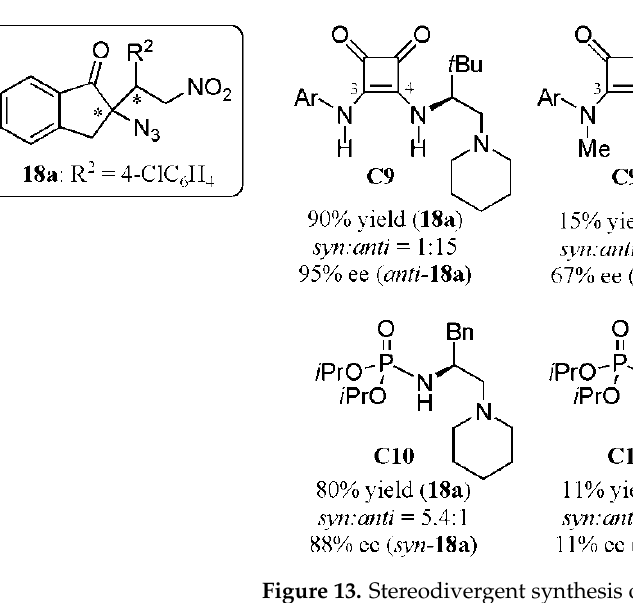
Figure 12. Stereodivergent Michael addition of α -azido ketones 1 7 to nitroolefins 7 [32].